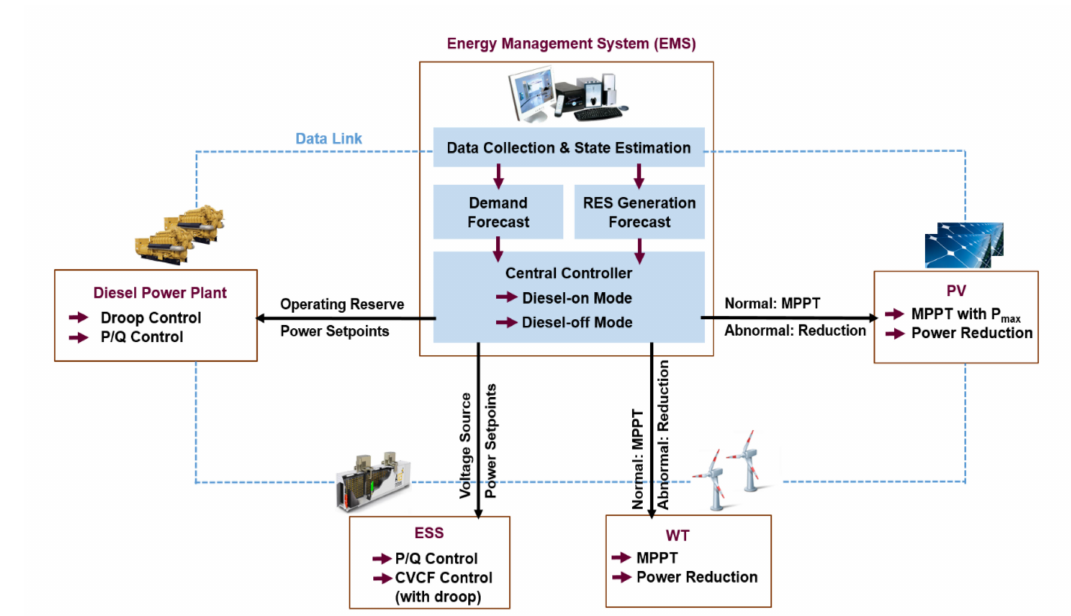
Figure 3. Microgrid control structure for Deokjeok